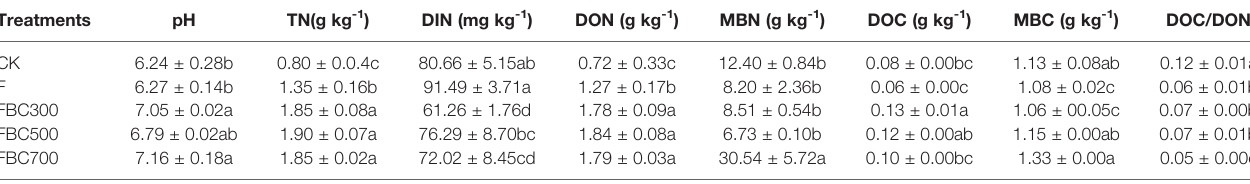
TABLE 3 | Soil pH, total N, dissolved inorganic N, dissolved organic N, microbial biomass N, dissolved organic C, microbial biomass C, DOC/DON ratio of topsoil (0- 10cm) collected after 55 days leaching . Treatments